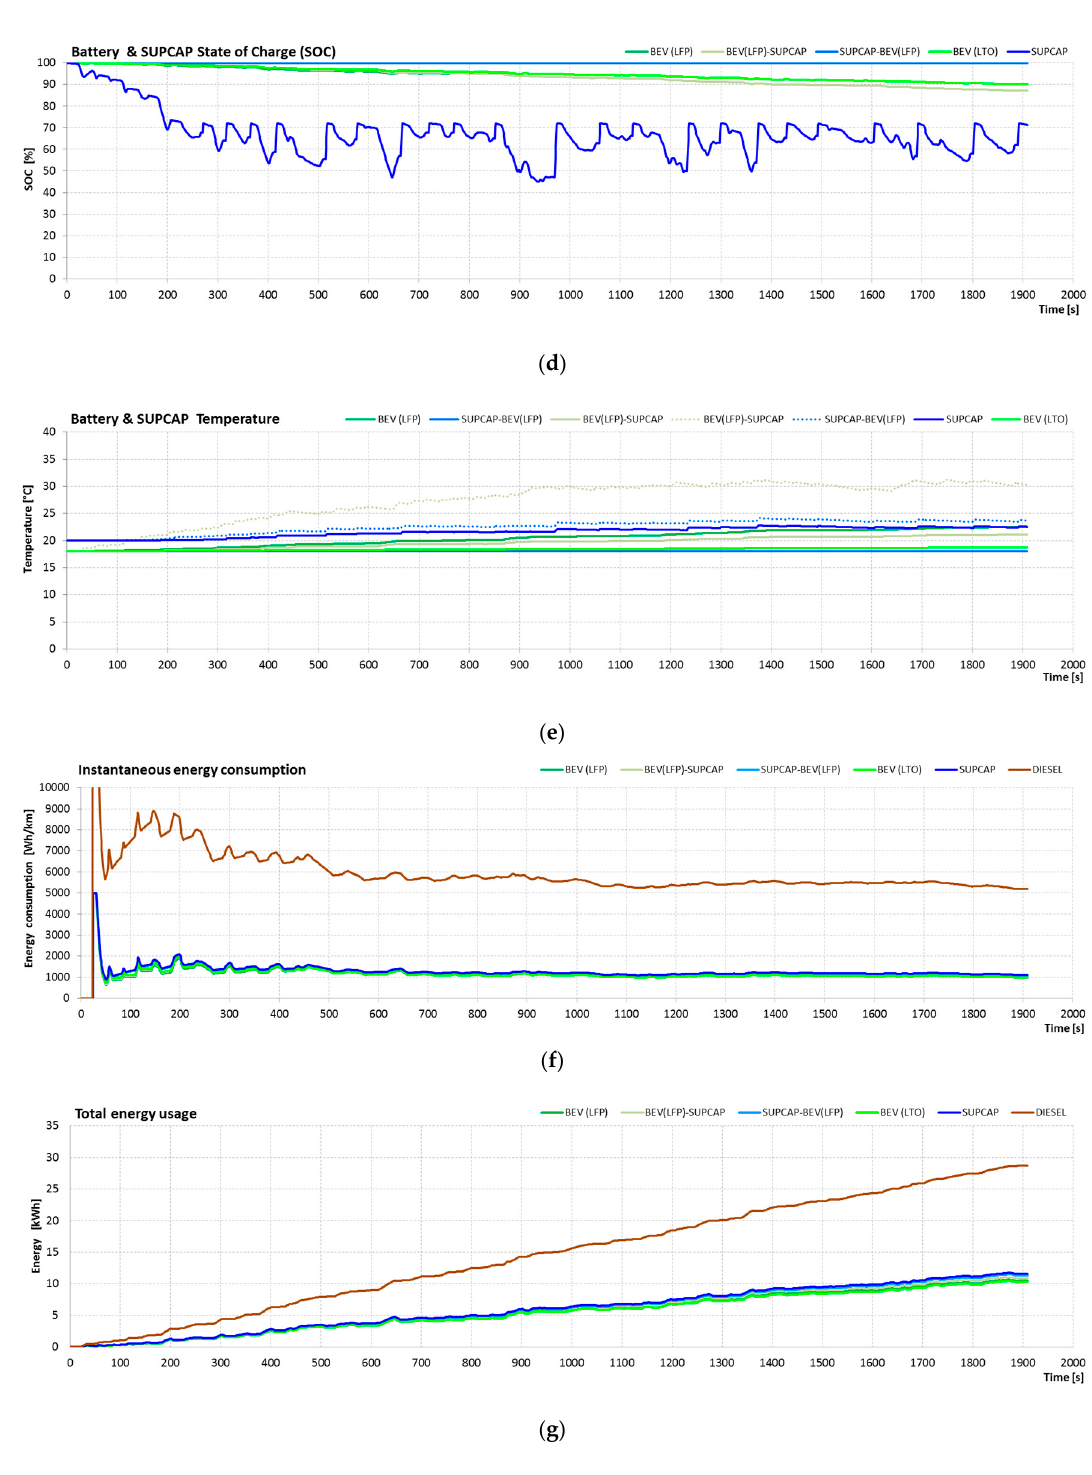
Figure 17. OCBC results of simulation tests, where: ( a ) Bus speed during tests (km/h); ( b ) Voltage and Current on DC-link (V), (A); ( c ) Motor/Engine Power (kW); ( d ) Battery & SUPCAP State of Charge (%); ( e ) Battery & SUPCAP temperature (°C); ( f ) Instantaneous energy consumption (Wh/km); ( g ) Total energy usage (kWh).